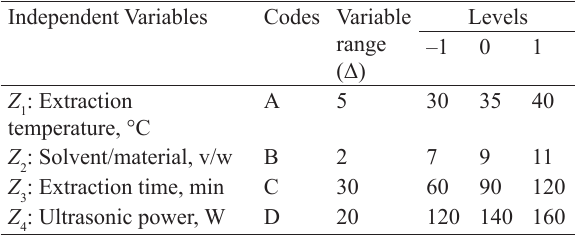
Table 1 Independent variables and their corresponding levels Independent Variables